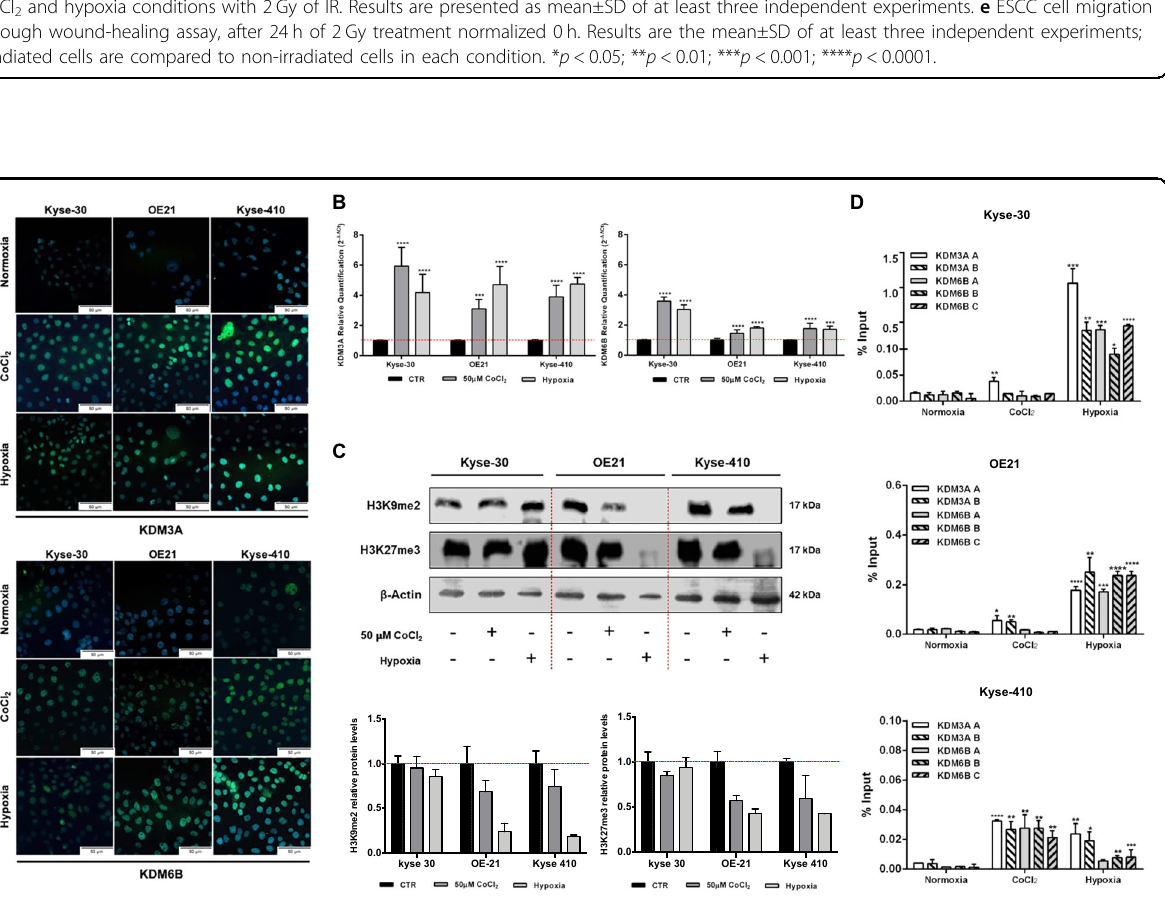
Fig. 2 JmjC-KDMs expression in ESCC cells under hypoxic conditions. a Nuclear KDM3A and KDM6B expression in normoxia and hypoxic (50 µM CoCl 2 or 0.5 – 1% O 2 ) conditions, by IF. All pictures are taken from Olympus IX51 microscope at ×200 magni fi cation (scale bar 50 μ m). b KDM3A and KDM6B transcript levels under normoxia and hypoxic (50 µM CoCl 2 or 0.5 – 1% O 2 ) conditions. Results represent the mean ± SD of at least three independent replicates, each one in triplicate; *** p < 0.001; **** p < 0.0001. Hypoxic conditions were compared to normoxia. c Representative images of total protein levels of H3K9me2 (17 kDa), H3K27me3 (17 kDa) under normoxia and hypoxic (50 µM CoCl 2 or 0.5 – 1% O 2 ) conditions. β -actin (42 kDa) was used as loading control. d HIF-1 α binding at KDM3A and KDM6B promoter region in normoxia and hypoxic (50 µM CoCl 2 or 0.5 – 1% O 2 ) conditions through ChIP assay. Values of 0.5 – 1% O 2 and 50 µM CoCl 2 were normalized to normoxia; * p < 0.05; ** p < 0.01; *** p < 0.001; **** p <